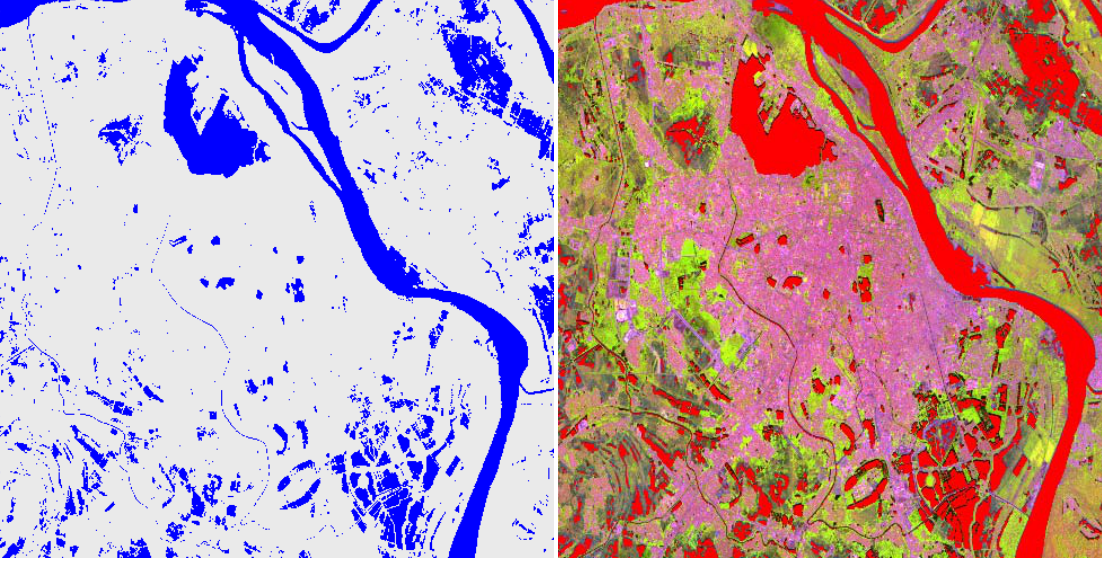
Figure 8. Water extraction by Spot 5 HRV image (left) and overlay on colour composite